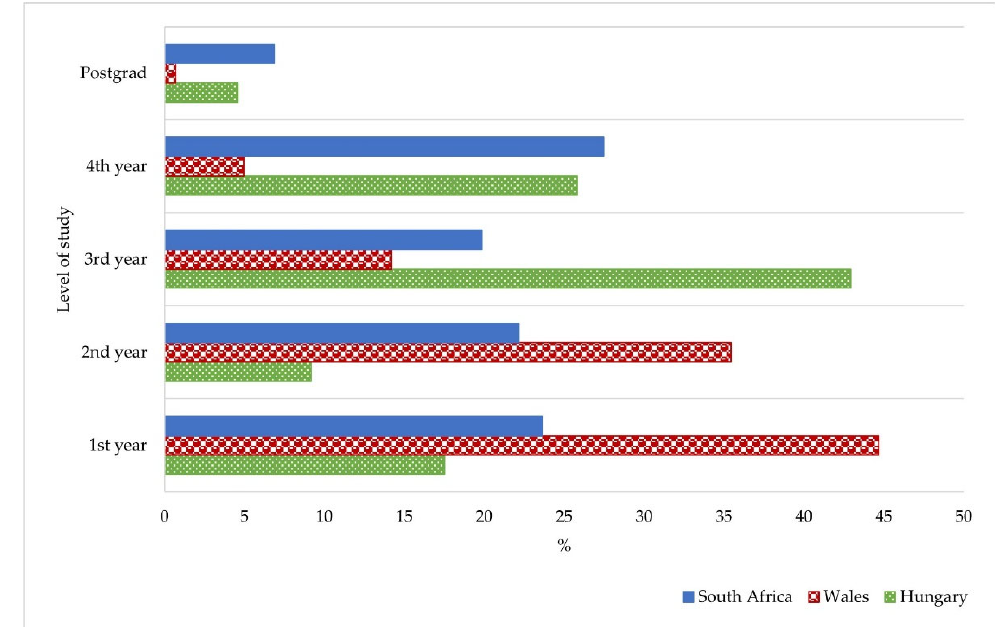
Figure 11. Student participants’ year of study by country (%).